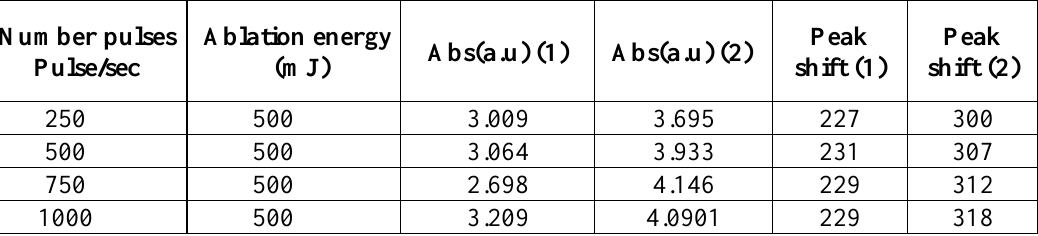
Fig.3: (a) CNP optical absorption spectrum prepared in an ethanol medium with multiple laser pulses (b) peak (minor) shift (c) peak (prominent) shift. Table 1: The optical properties of